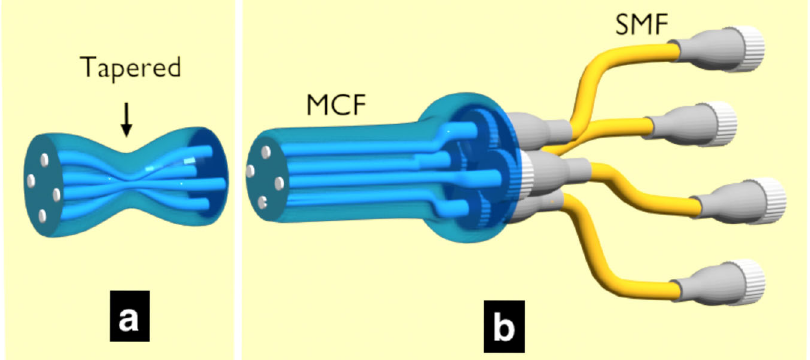
Fig. 2 Examples of multi-core optical fi ber devices. a 4 × 4 multi-core fi ber beam splitter. b Single-mode to multi-core fi ber multiplexer train of 5 ns width quasi-Gaussian pulses at a repetition rate of 2.78 MHz. The pulses are attenuated and sent into a SMF 50/50 fi ber beam splitter (BS0), resulting in two WCSs. One of them is